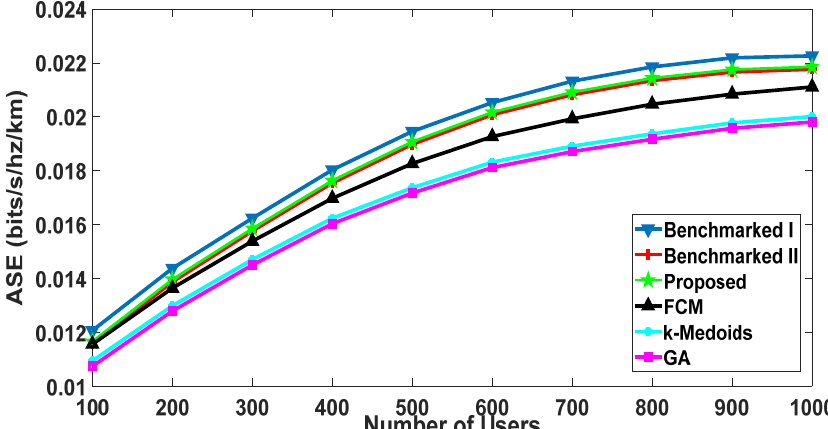
Figure 18. ASE: comparison with the benchmarked schemes ( 𝑤 (cid:2869) (cid:3404) 𝑤 (cid:2870) (cid:3404) 0.1,𝑤 (cid:2871) (cid:3404) 0.8 ).